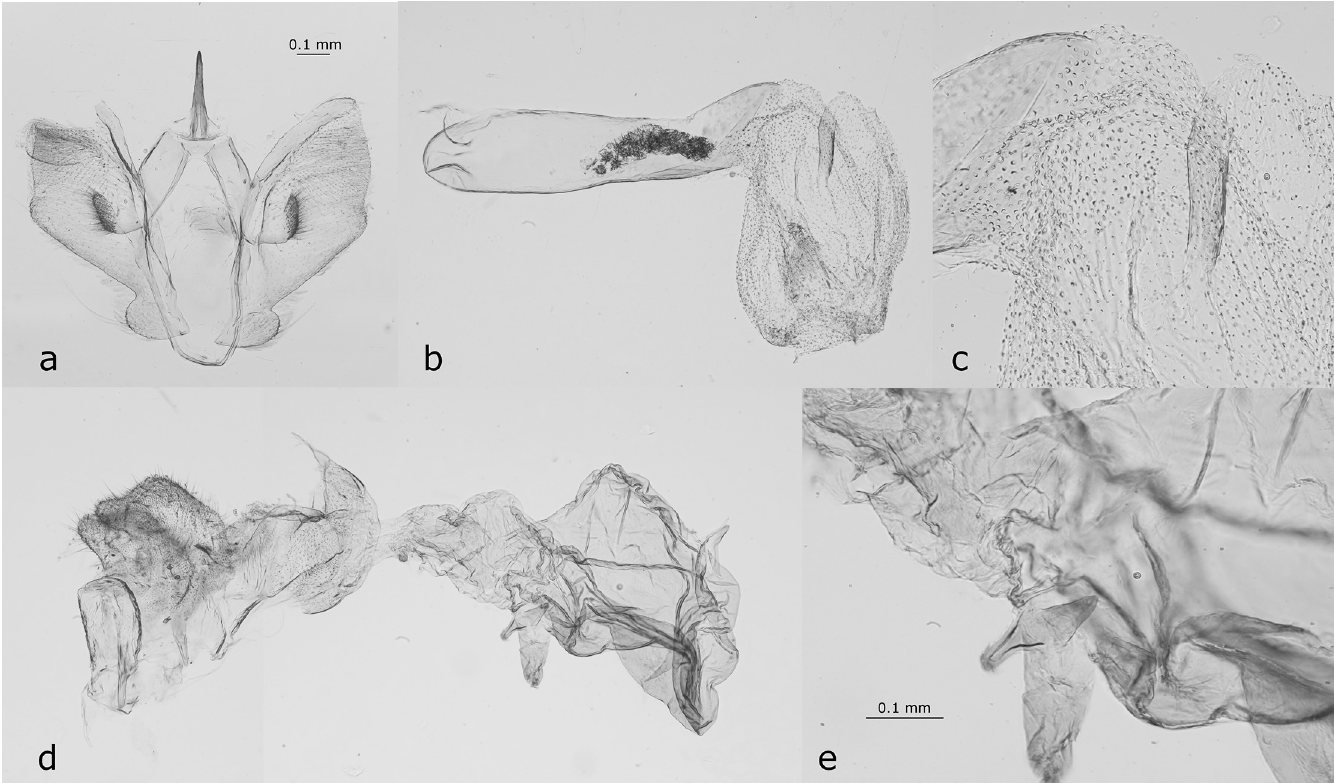
Fig 1. The male (a-c) and female (d-e) genitalia of Levuana iridescens . a) valvae, b) phallus, c) phallus (detail), d) female genitalia, e) female genitalia (detail). The scale bars for overview (a,b,d) and detail (c,e) views are the same. The female is missing the corpus bursae, and only the papillae anales, ostium, proximal part of the ductus bursae and the praebursa are visible. Dissections by Gerhard Tarmann from USNM specimens.